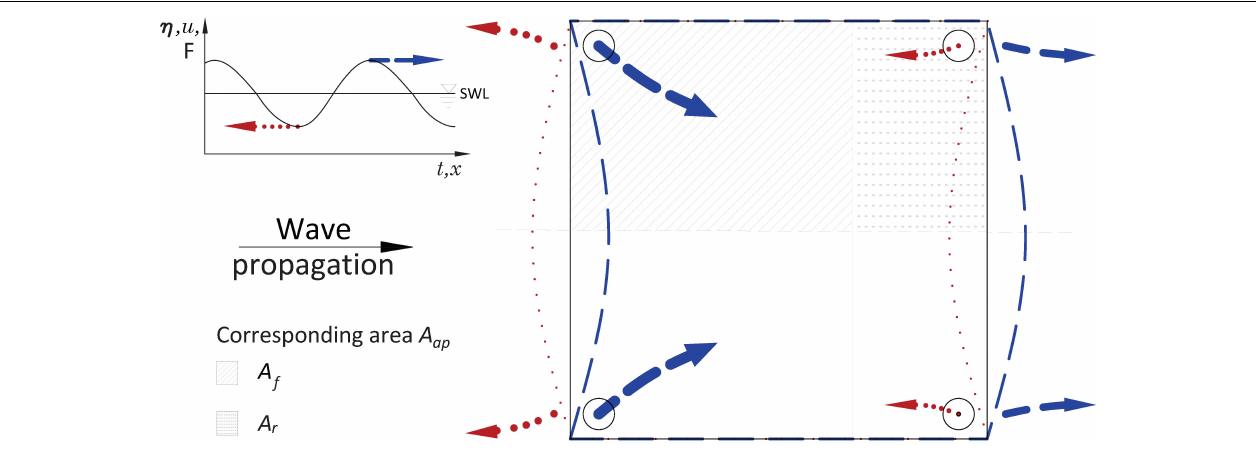
FIGURE 5 | Qualitative scheme of the predominant directions of the resultant forces in direction of wave propagation (blue dashed line) and in opposite direction (red dotted line) for the 4-anchor configuration and respective (exaggerated) deformation of the mat with the corresponding area for each anchor ( A ap ) for the direction of wave propagation. The solid gray line denotes the original mat position. SWL = Still Water